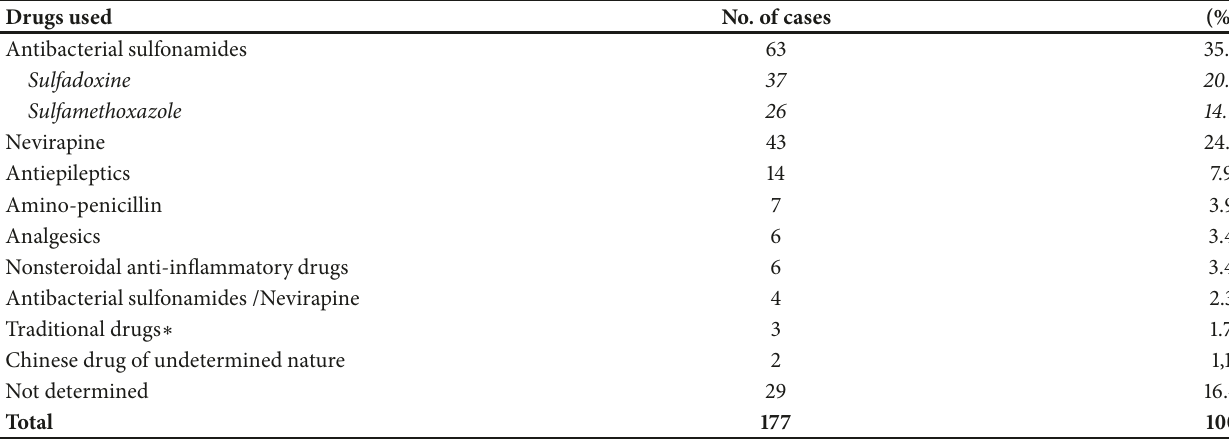
Table 1: Drugs implicated in the cause of SJS/TEN.